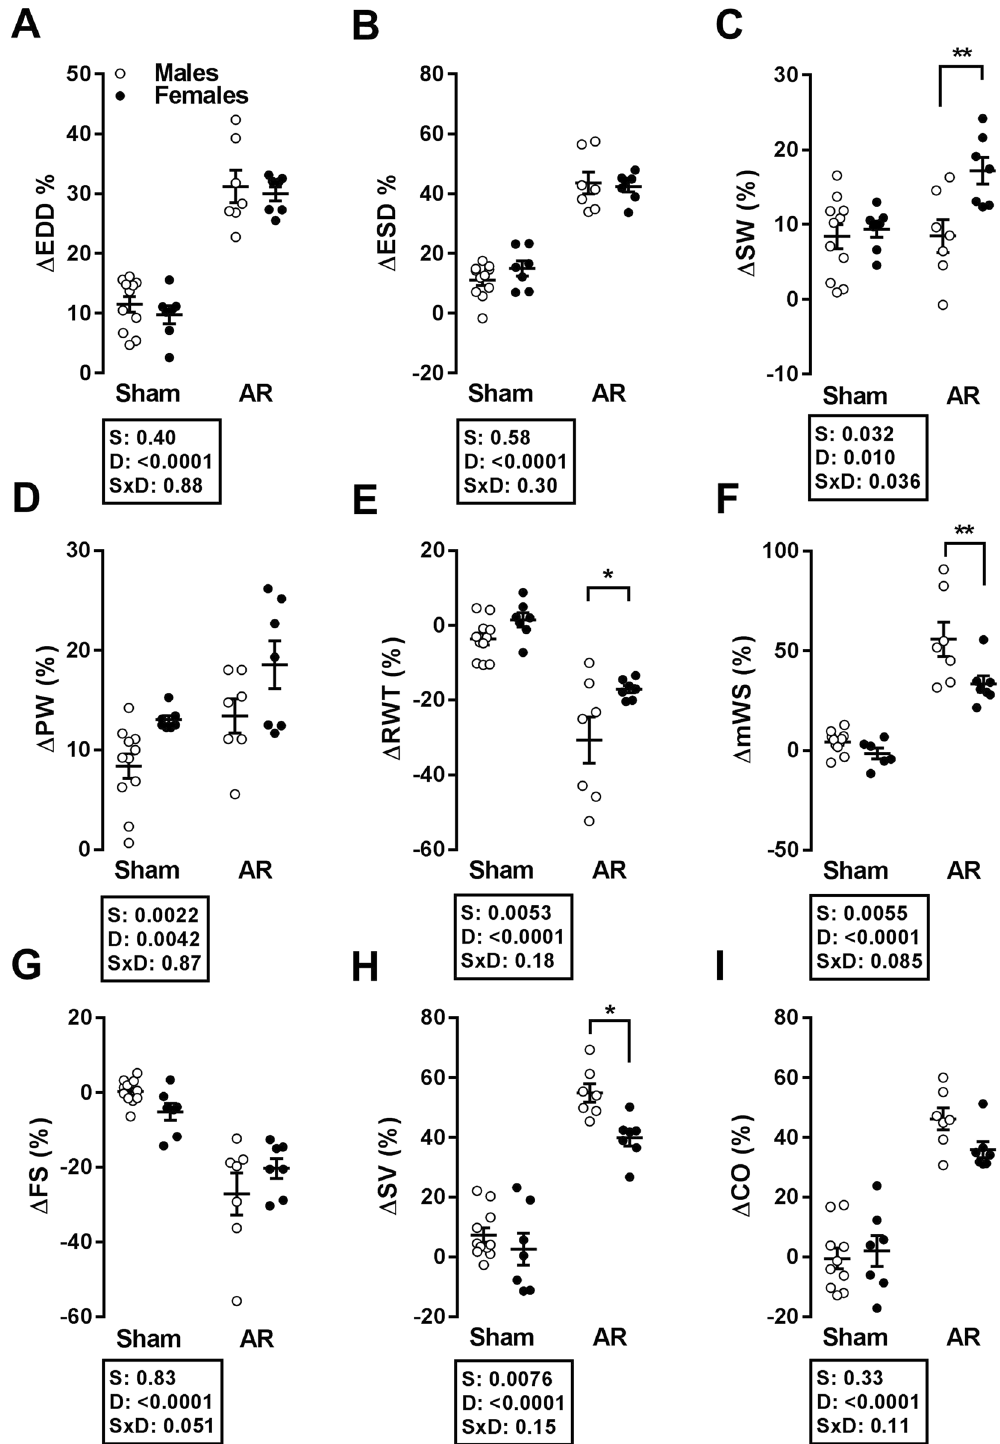
Figure 1. Progression of different LV parameters as evaluated by echocardiography during the duration of the study (26 weeks). Δ : % difference between week 0 and week 26, EDD: end-diastolic diameter ( A ), ESD: end-systolic diameter ( B ), SW: septal wall thickness ( C ), PW: posterior wall thickness ( D ), RWT: relative wall thickness ( E ), mWS: mean wall stress ( F ), FS: fractional shortening ( G ), SV: stroke volume ( H ) and CO: cardiac output ( I ). The results are reported in % as the mean ± SEM (n = 7–11/gr). Probability values from a 2-way ANOVA and Holm-Sidak post-testing to evaluate the p value of sex, (S), disease (D) or disease-sex interactions (S × D) are shown next to each